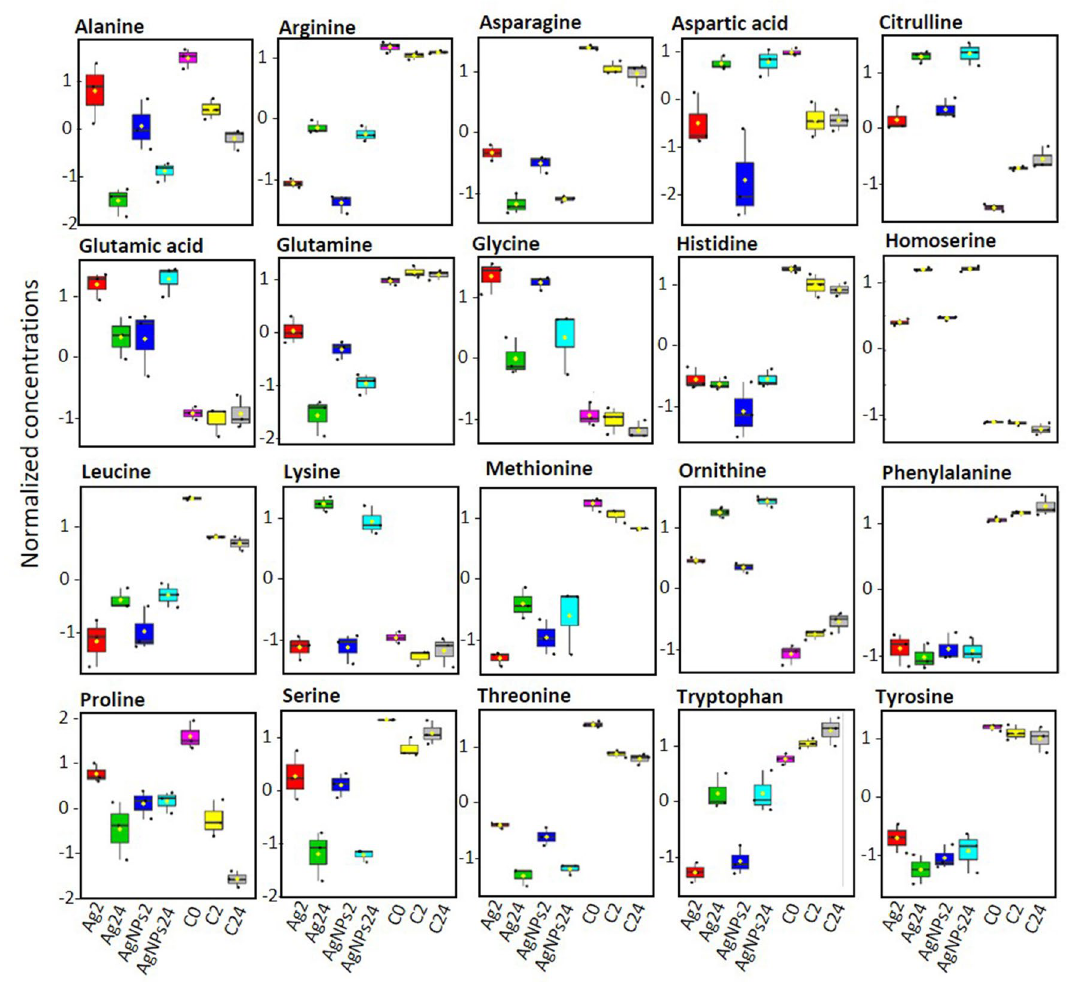
Figure 5. Box plots of relative abundance of amino acids in P. malhamensis in Ag-treatments and untreated controls. Data were normalized by using probabilistic quotient normalization by untreated control group at time 0 (C0), log transformed and autoscaled. Exposure to 40.7 μg L −1 AgNO 3 for 2 h (Ag2) and 24 h (Ag24); exposure to 1 mg L −1 AgNPs for 2 h (AgNPs2) and for 24 (AgNPs24); C2: unexposed controls at time 2 h; C24: unexposed controls at time 24